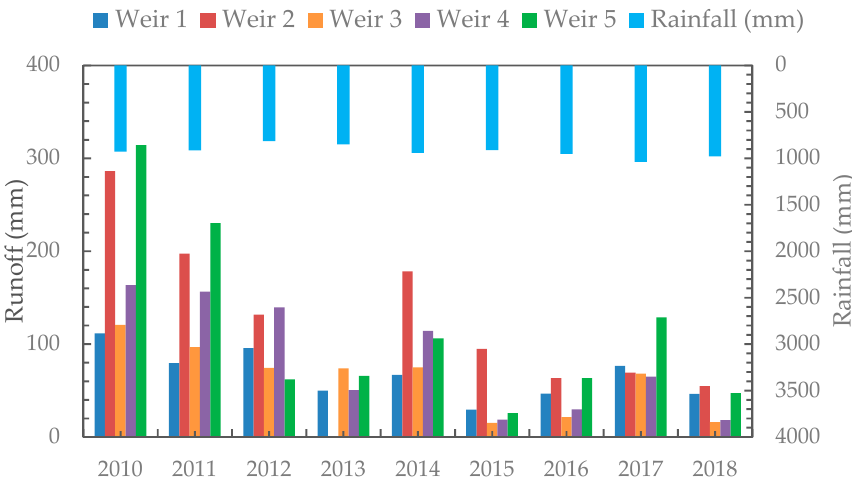
Figure 5. Precipitation and discharge in Debre Mawi watershed from 2010 to 2018.